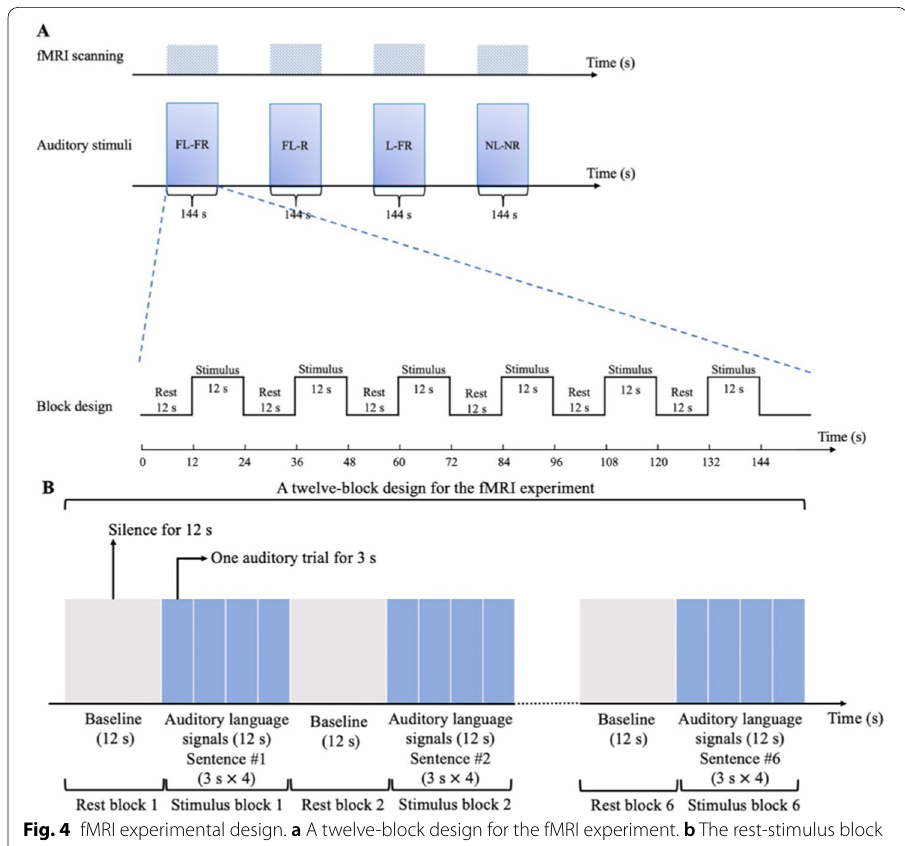
Fig. 4 fMRI experimental design. a A twelve-block design for the fMRI experiment. b The rest-stimulus block design for the fMRI